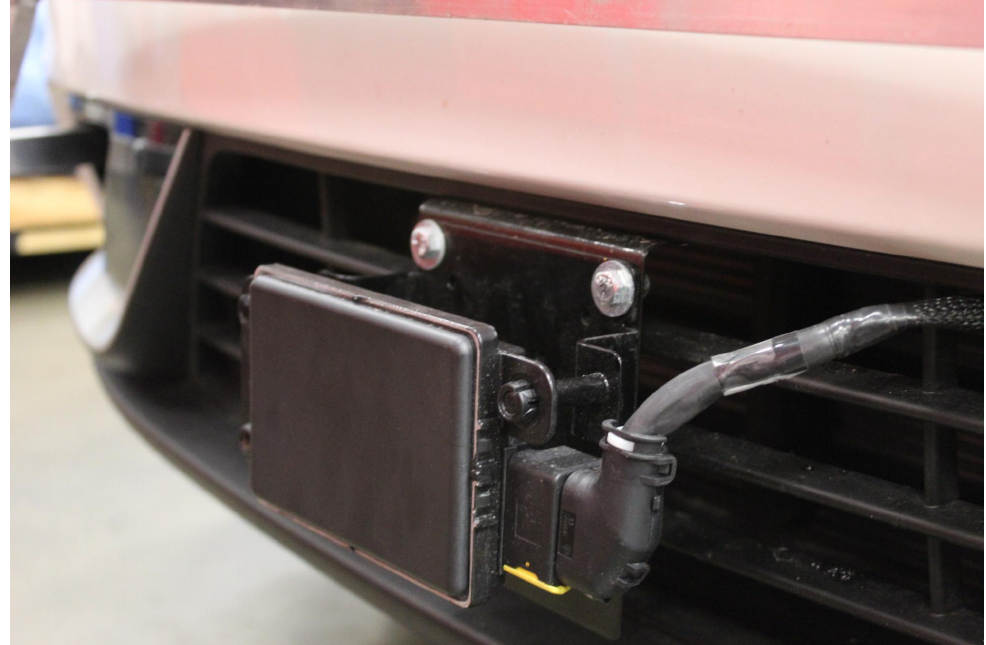
Figure 7. The bracket is mounted to the bumper behind the bumper cover of the vehicle for struc- tural